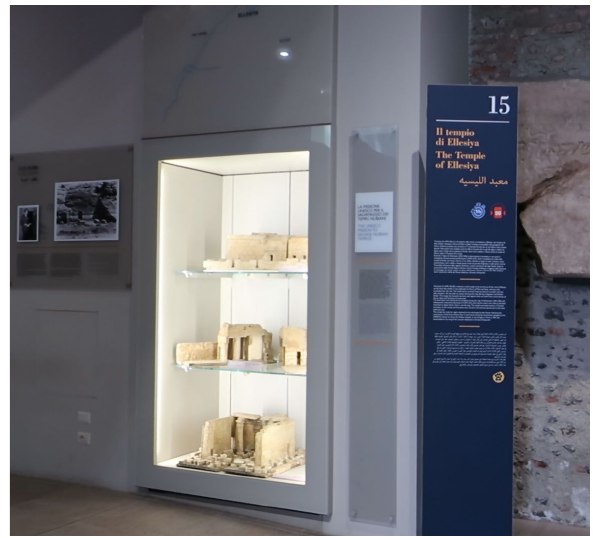
Figure 2. The architectural models displayed in the Nubian Room at the Museo Egizio of Turin